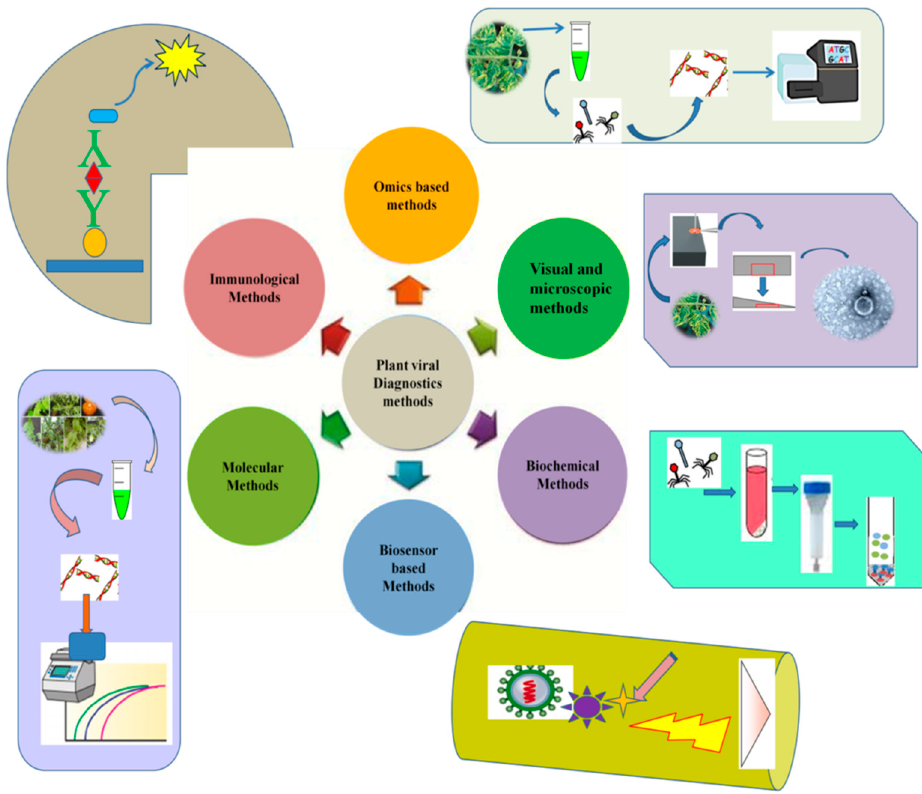
Figure 1. Common diagnostic methods used for plant viral identification and disease diagnosis of various crop plants.